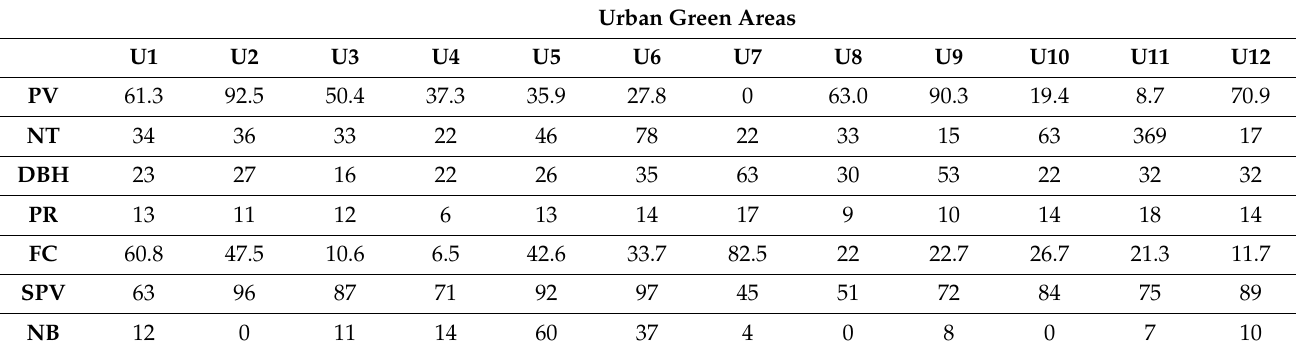
Table 2. Environmental conditions of 12 urban green areas studied in Campos dos Goytacazes/RJ. Inside UGA: percentage of paving (PV), number of trees (NT), diameter at breast height (DBH), plant richness (PR), flower coverage in m 2 (FC). Surrounding conditions measured inside a buffer of 500 m from UGA center: surrounding paved area percentage (SPV) and the number of buildings with more than three floors (NB).